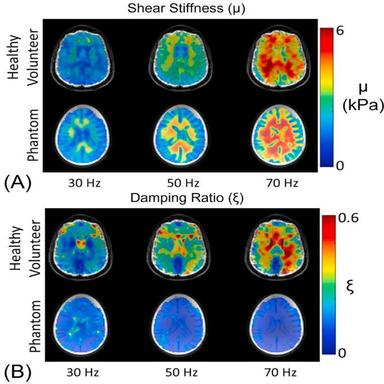
Measurements of shear stiffness (μ) and damping ratio (ξ) were obtained from magnetic resonance elastography (MRE). (A) Shear stiffness and (B) damping ratio are shown as a function of actuation frequency in a healthy volunteer and the ANGUS phantom. Shear stiffness increases as a function of frequency in both the healthy volunteer and ANGUS phantom; damping ratio increases in the healthy volunteer but decreases in ANGUS.